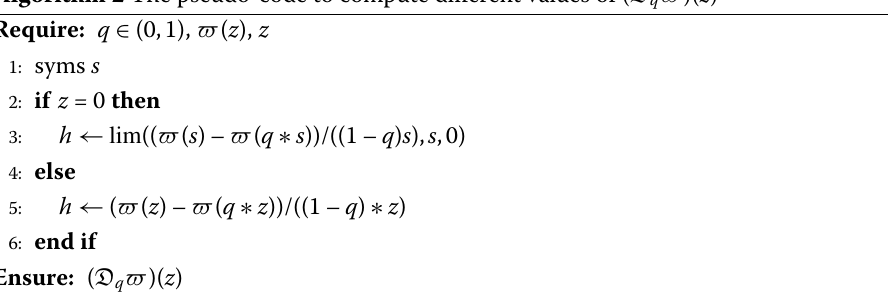
Algorithm 2 The pseudo-code to compute different values of ( D q (cid:3) )( z